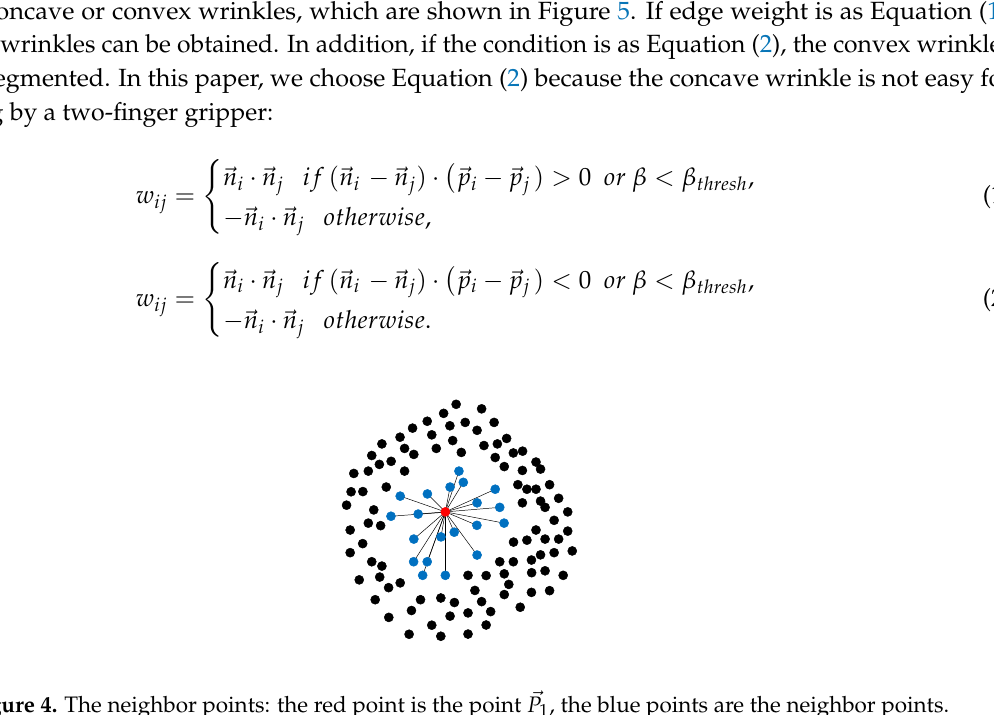
Figure 4. The neighbor points: the red point is the point (cid:126) P 1 , the blue points are the neighbor points.